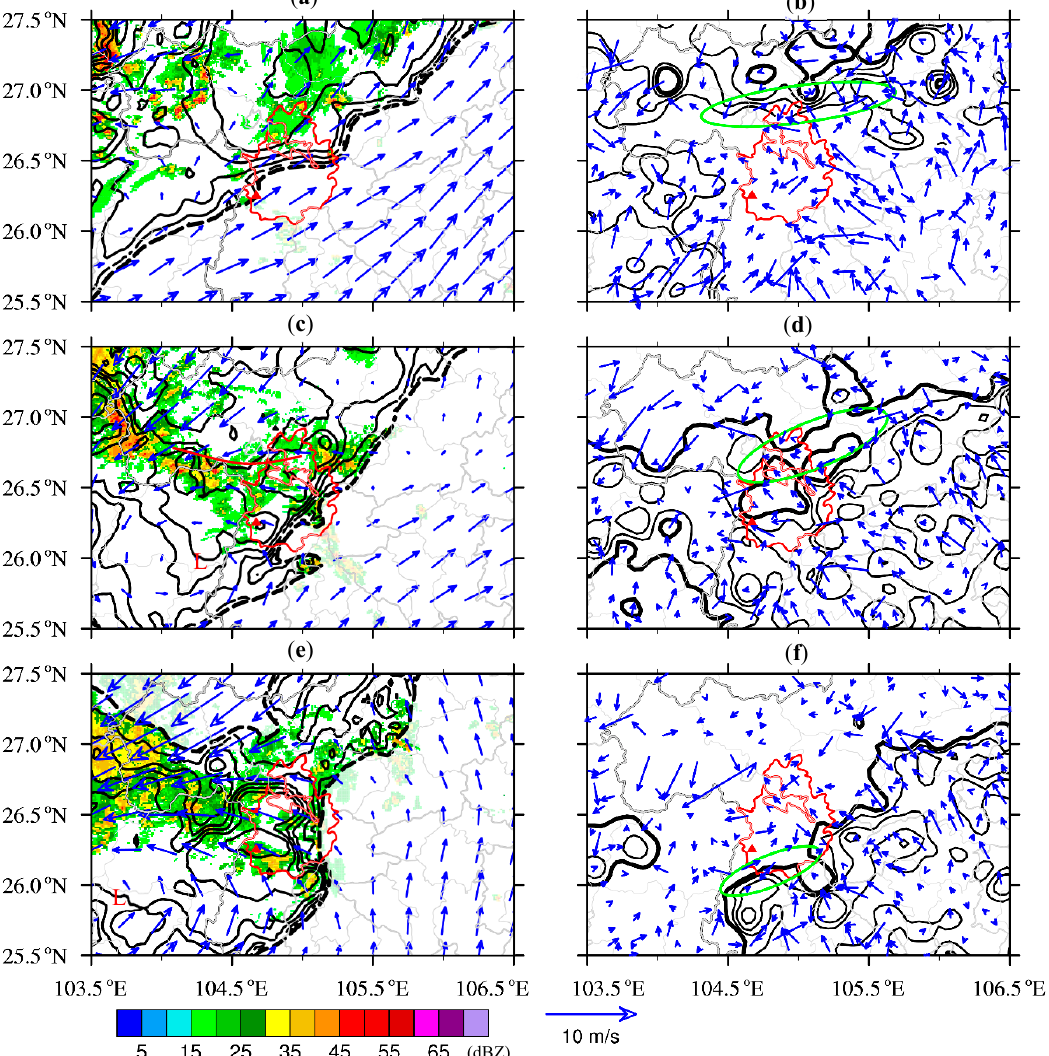
Figure 4. (Left panel) Radar composite reflectivity (shaded, dBZ) overlaid by the FY-4 satellite TBB (contours, K) and horizontal wind vectors (vectors, m/s) at 700 hPa from ERA5 reanalysis data; (right panel) θ e (contours, unit: K) overlaid by surface winds (vectors, m/s) at ( a , b ) 09:00 UTC; ( c , d ) 12:00 UTC; ( e , f ) 14:00 UTC on 22 July 2019. The black dotted lines in the left panel represent the 221 K isolines of the identified MCSs (region with TBB ≤ 221 K). The TBB is contoured at intervals of 5 K. The red solid lines denote the convergence line, and “L” denotes a low-vortex system. The light-shaded colors are the composite reflectivity values outside the MCSs. The thick black solid lines in the right panel represent the value of 356 K in the θ e fields and 2 K contour intervals.